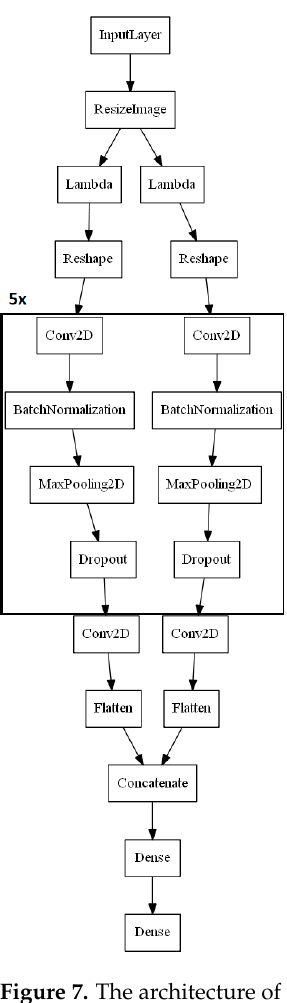
Figure 7. The architecture of CustomKSM model.